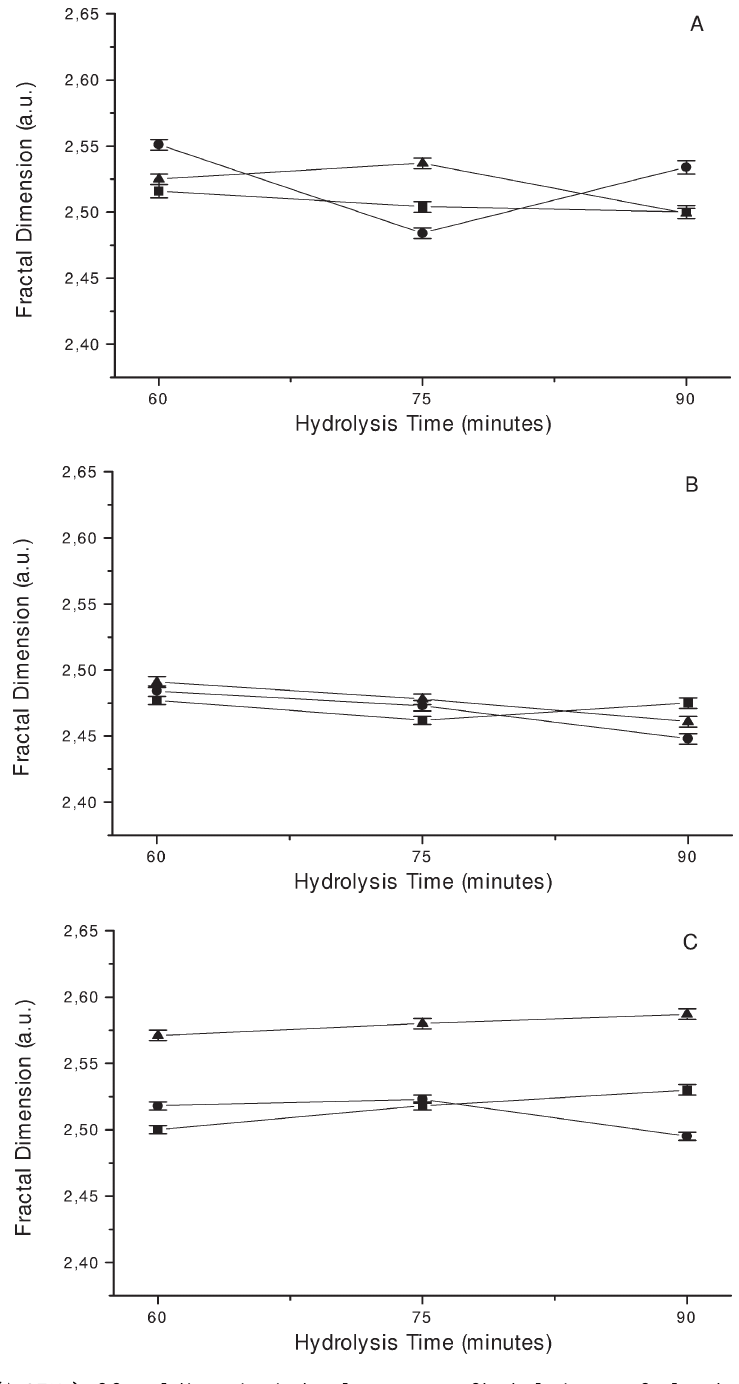
Fig. 5. Mean values ( (cid:6) SEM) of fractal dimension in the plateau range of hydrolysis curve for lymphatic cells (A), epithelial cells from buccal mucosa (B) and uterine myometrial cells (C) fixed by different types of fixatives: (cid:4) – Delaunay, (cid:15) –